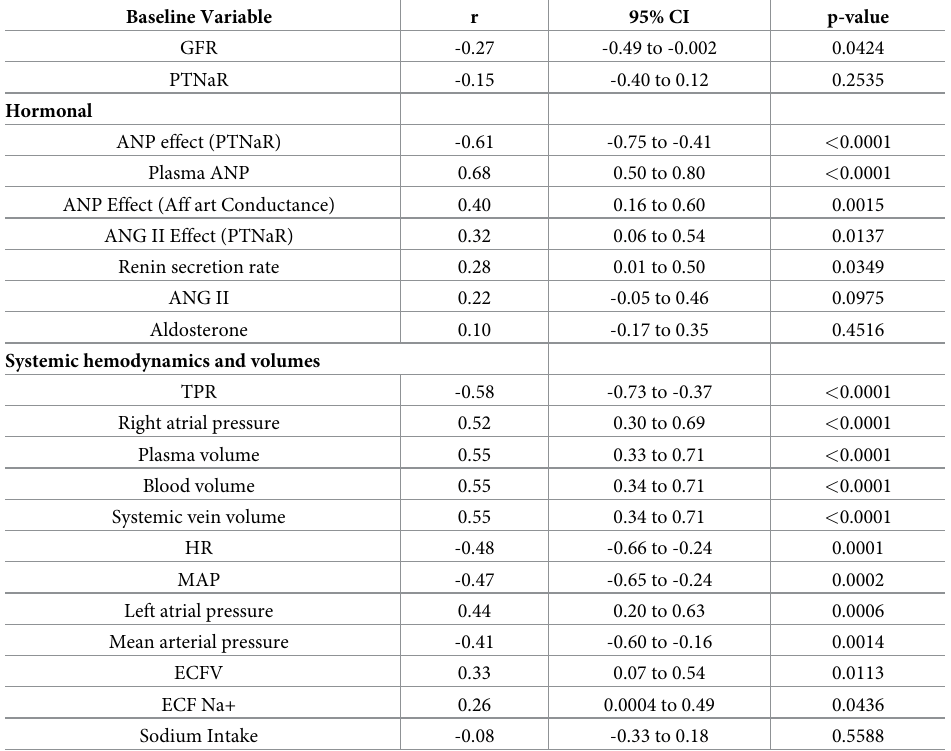
(Fig 6). For example, in the ANP+RSNA Clamp group, efferent arteriolar resistance and MAP did not fall as much which resulted in significantly higher GFR (155 ± 13 mL/min) as com- pared to the BAT Control simulation (150 ± 13 mL/min). Further, the change in afferent arte- riolar resistance reflected changes in TGF, which was primarily dependent upon macula densa sodium delivery and renal perfusion pressure (i.e. MAP). Clamping RSNA and/or ANP resulted in a significant increase in afferent resistance after 1 month of BAT relative to the con- trol simulation (Fig 6C). Finally, PTNaR and collecting duct sodium reabsorption significantly decreased upon initiation of BAT and remained below baseline over the next month in the BAT control simulation (Fig 6E and 6F). As compared to control, this chronic decrease in sodium reabsorption was significantly blunted in the proximal tubule with RSNA clamping (-8 ± 5% vs. -4 ± 6%, respectively) and in the collecting duct by clamping ANP (-7 ± 10% vs. 3 ± 11%, respectively) (Fig